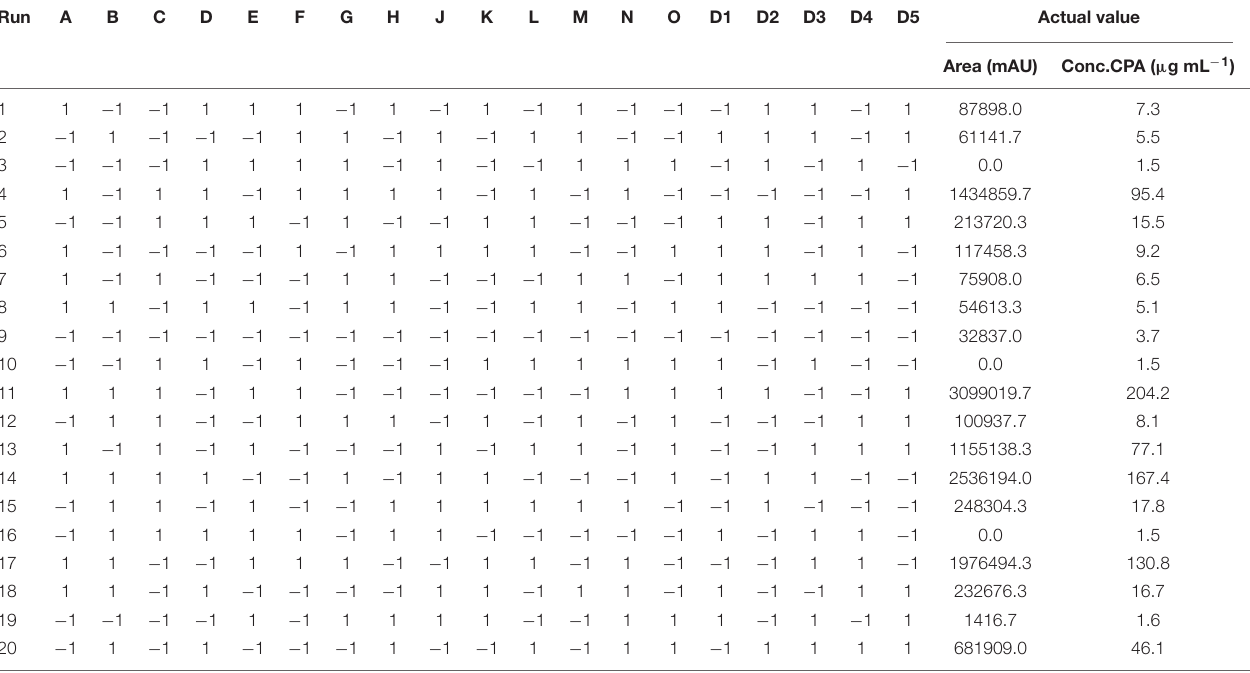
TABLE 3 | Twenty-trial Plackett–Burman experimental design for evaluation of independent variables with coded values along with the observed cyclopiazonic acid. Run